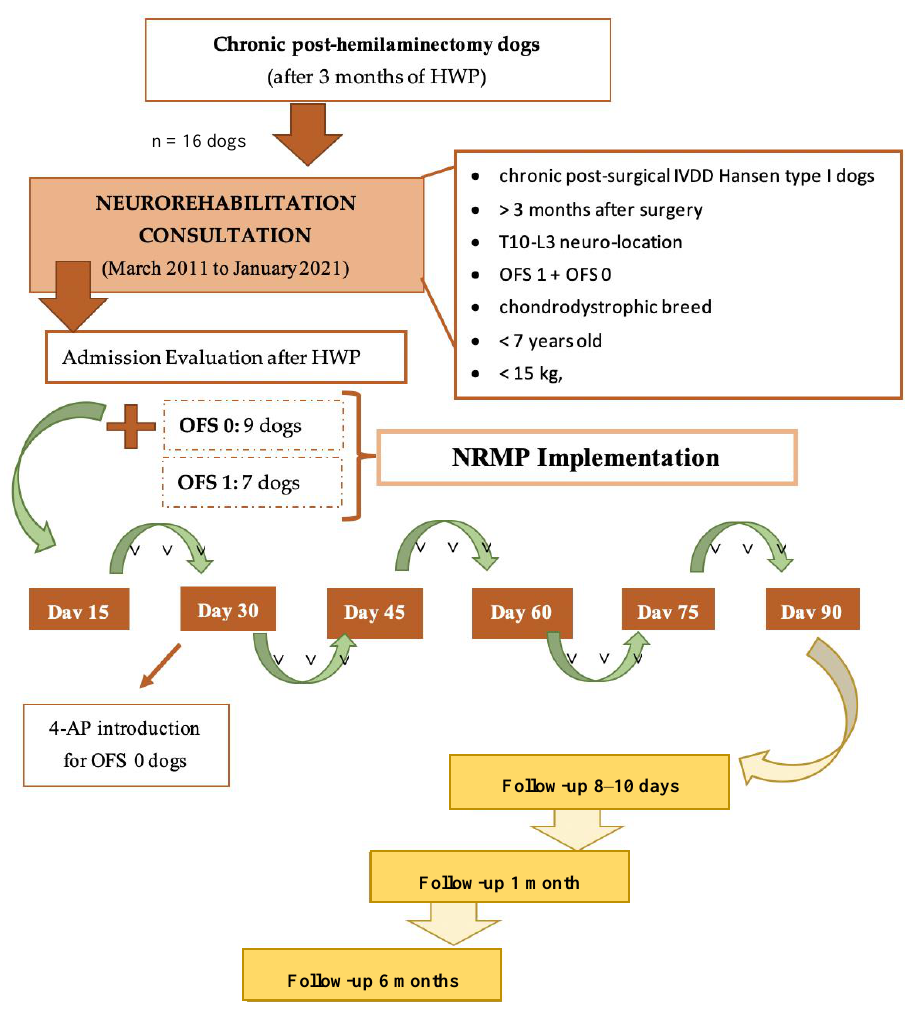
Figure 3. Flow diagram illustrating the study design of chronic paraplegic post-hemilaminectomy dogs. Abbreviations: OFS—open field score [64]; NRMP—neurorehabilitation multimodal protocol; HWP—Home Work Plan; SRL—Spinal Reflex Locomotion; NSRL—Non-Spinal Reflex Locomotion.